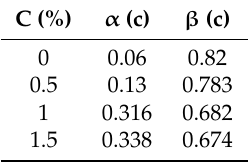
Table 2. α and β parameters deduced from the fitted curves displayed in Figure